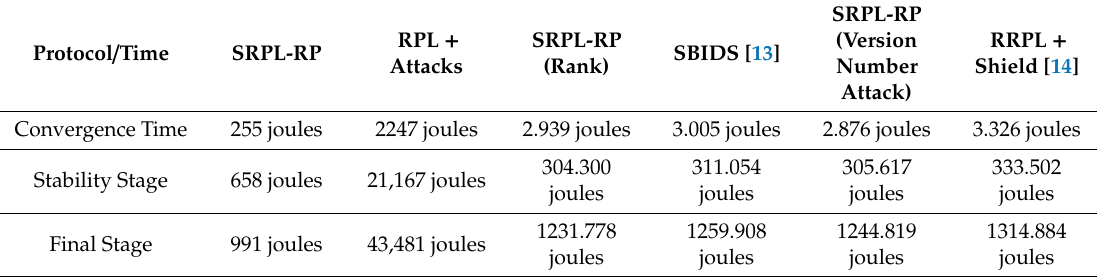
Table 11. Average Energy Consumption Comparison in Random